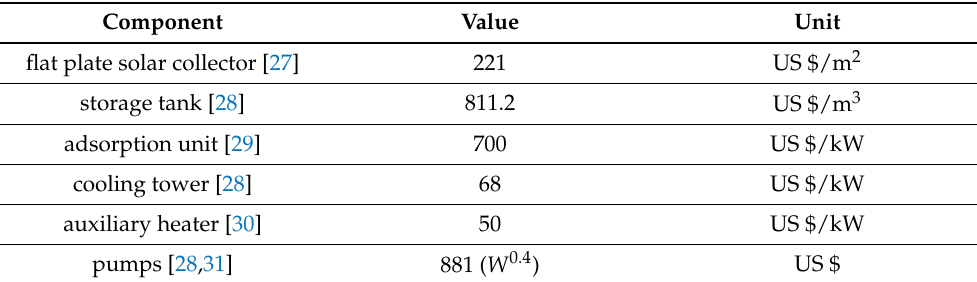
Table 2. The investment cost of each main component.